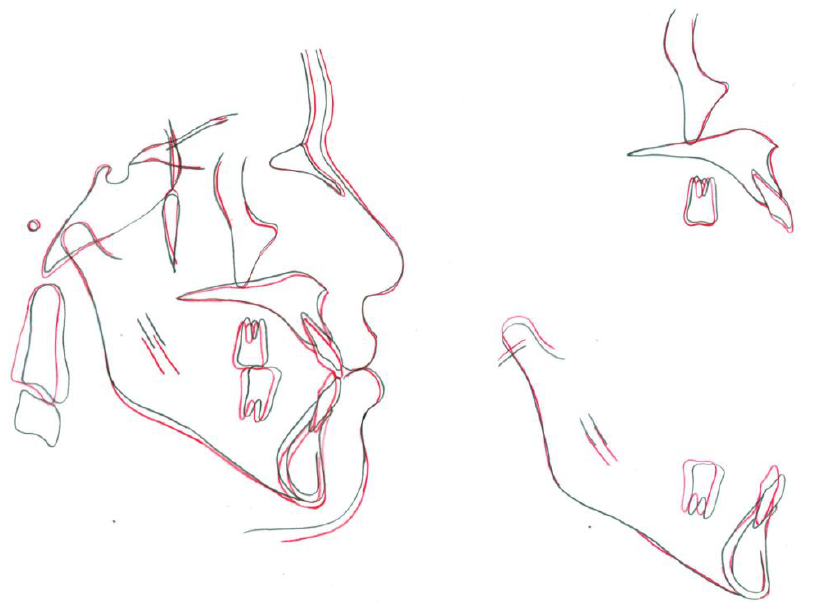
Figure 4. Superimpositions of pretreatment (black line) and posttreatment (red line) cephalometric tracings.